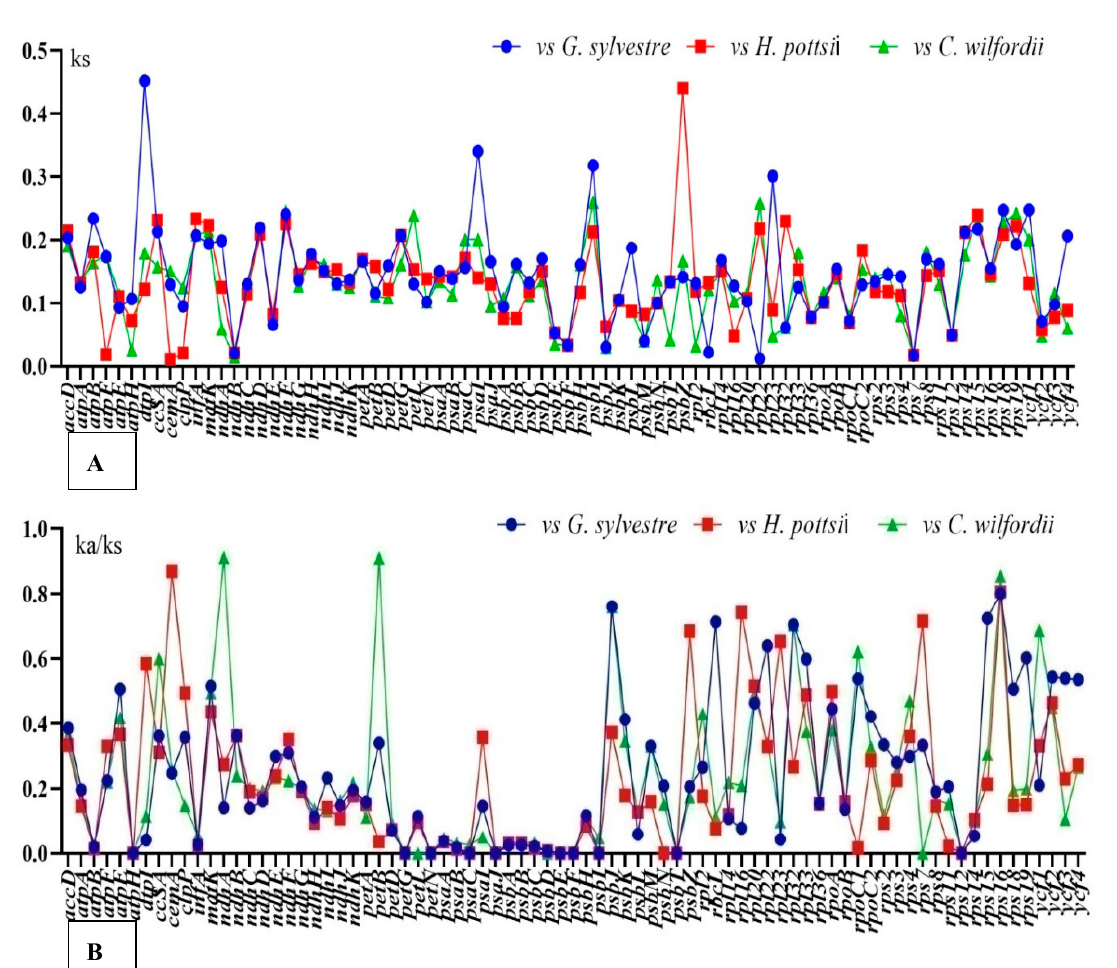
Fig. 8: Ka/Ks ratio of C. quadrangula against G. sylvestre, H. pottsii , and C. wilfordii